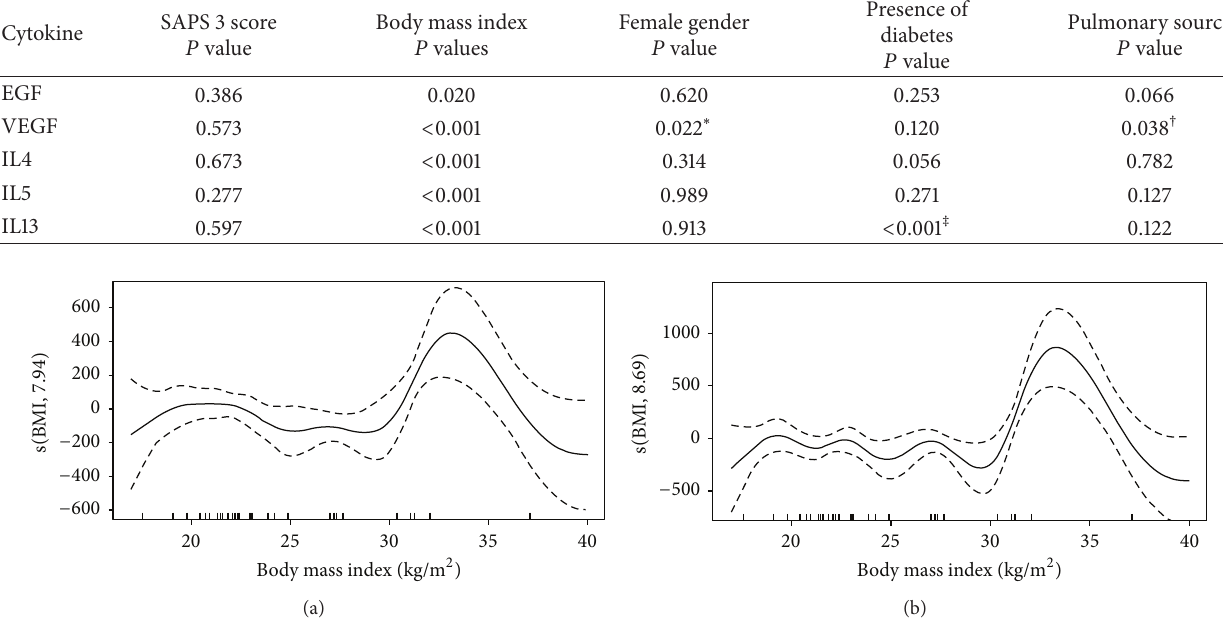
Table 3: Results for the additional model built for EGF, VEGF, IL4, IL5, and IL13. This model included SAPS 3 score, BMI, gender, pulmonary source, and presence of diabetes. Estimates (SE) values are as follows: ∗ 163.75 (67.80); † 150.95 (69.41); ‡ − 20.23 (7.00).